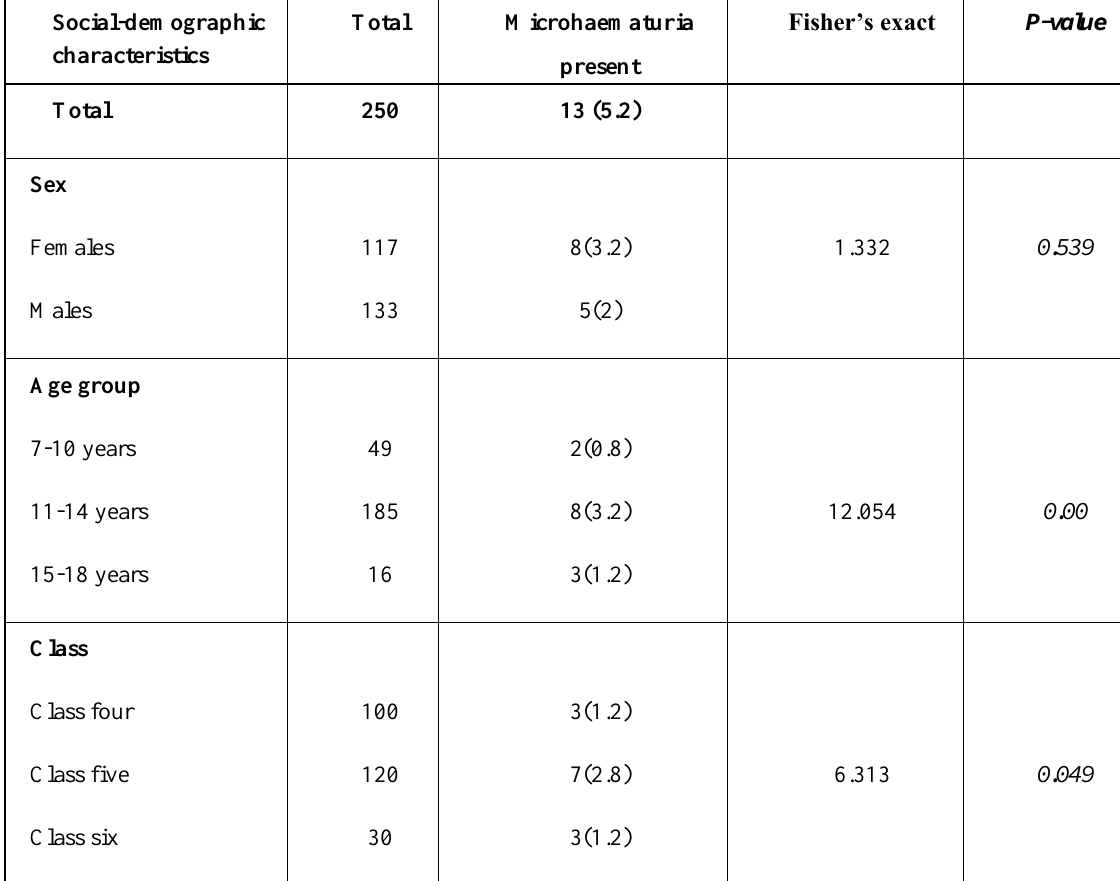
Table 2. Prevalence of microhaematuria among primary school children (n=250). Social-demographic